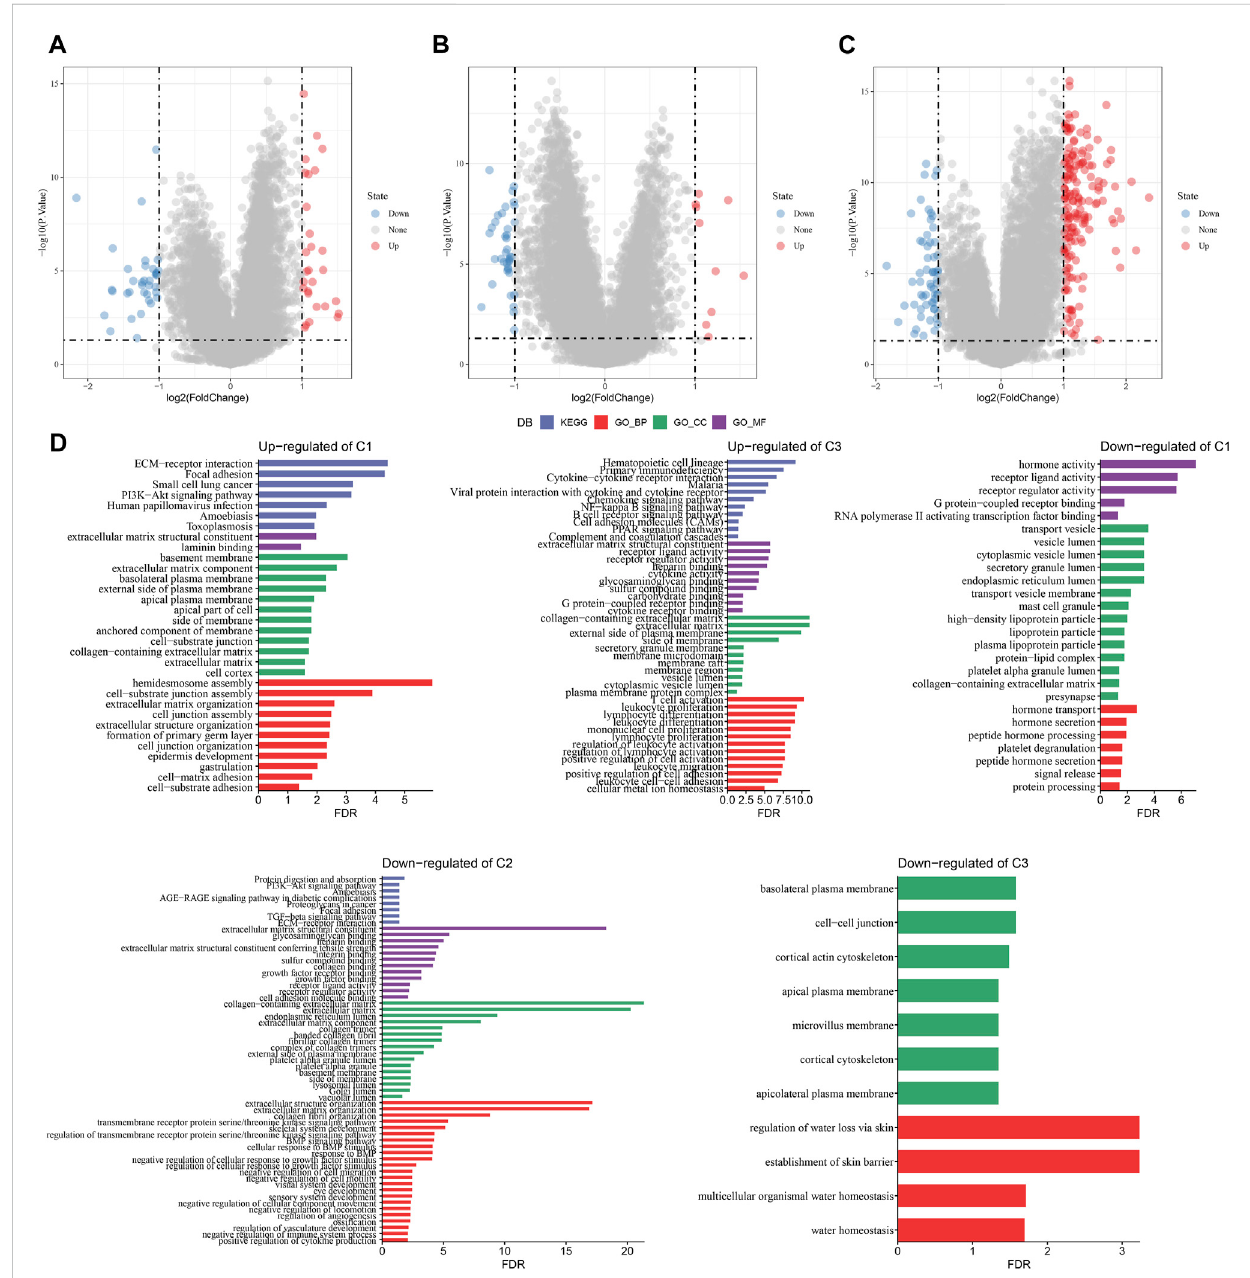
FIGURE 6 The identi fi cation of DEGs in each cluster. (A – C) Volcano plot of DEGs in the TCGA-PAAD cohort; (D) Functional enrichment analysis of DEGs of each